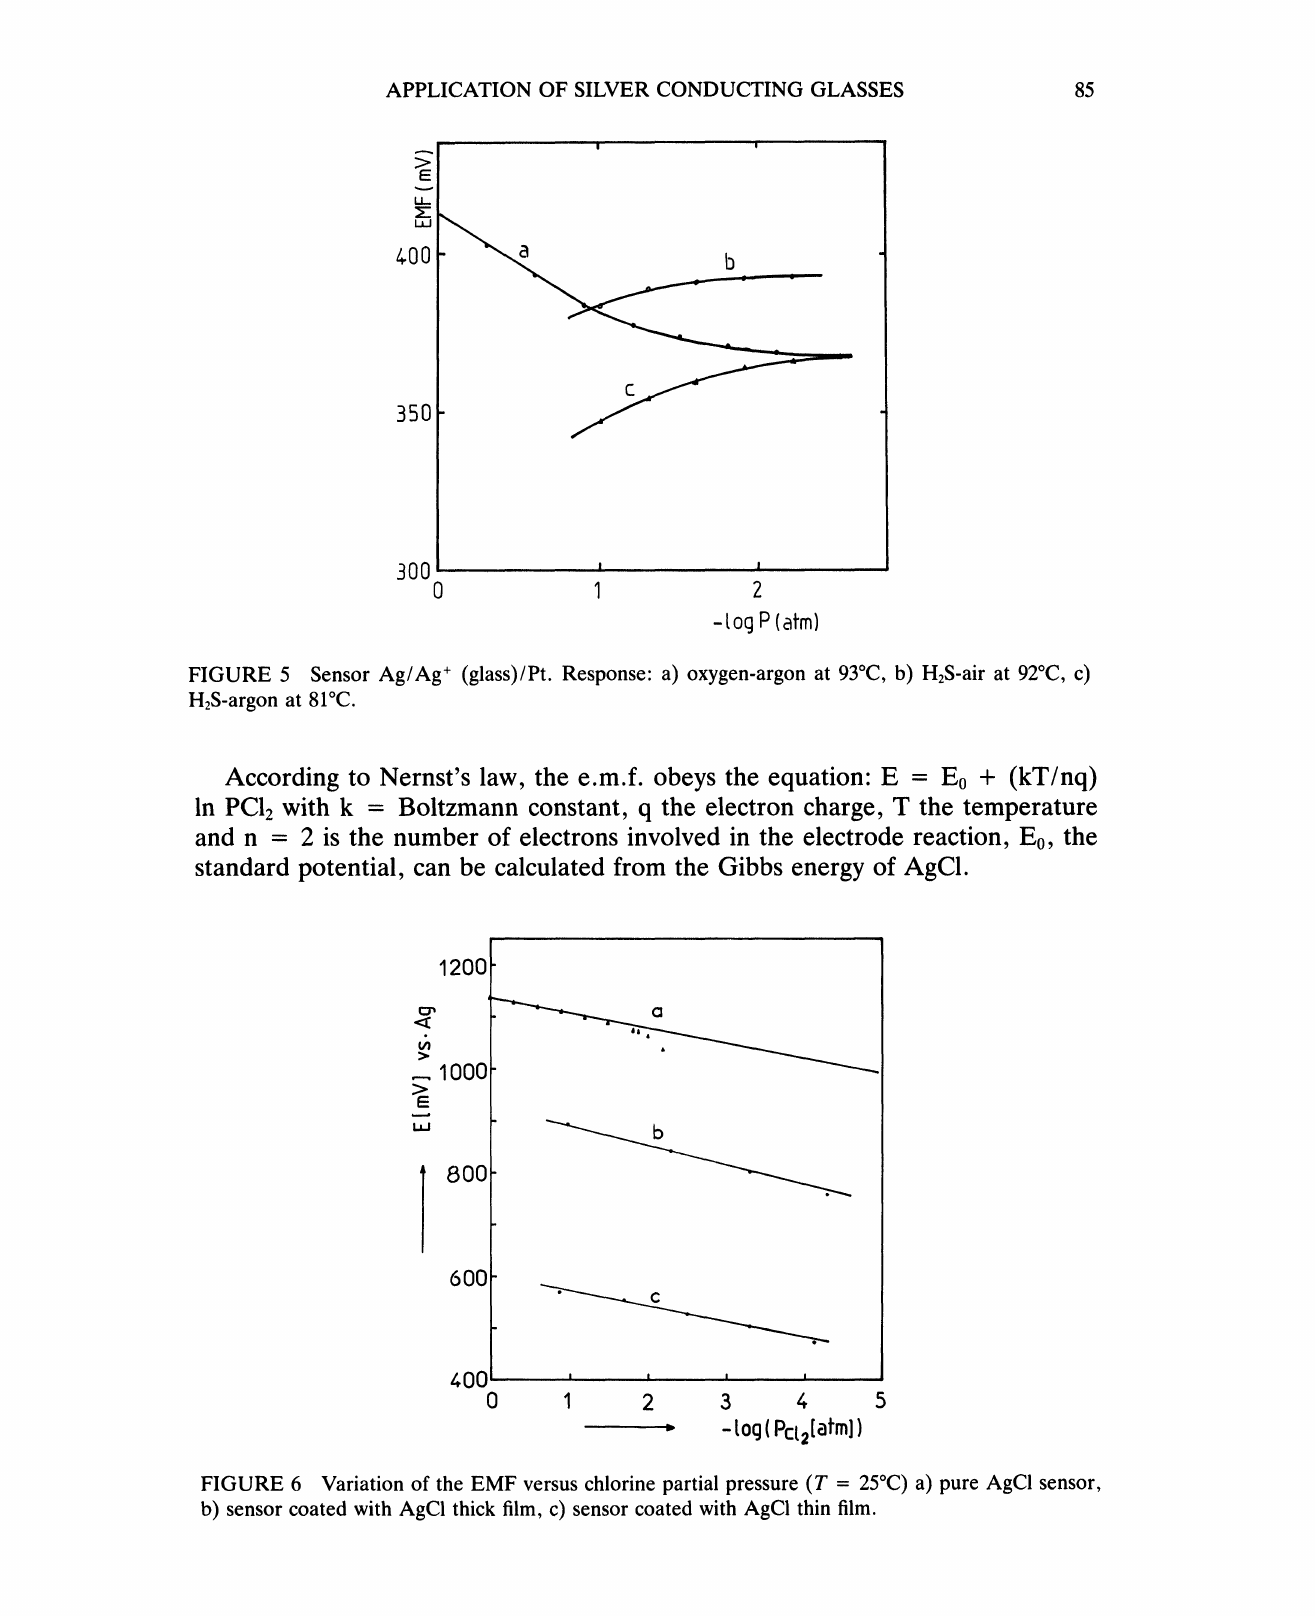
FIGURE 6 Variation of the EMF versus chlorine partial pressure (T 25C) a) pure AgCI sensor, b) sensor coated with AgO thick film, c) sensor coated with AgCI thin